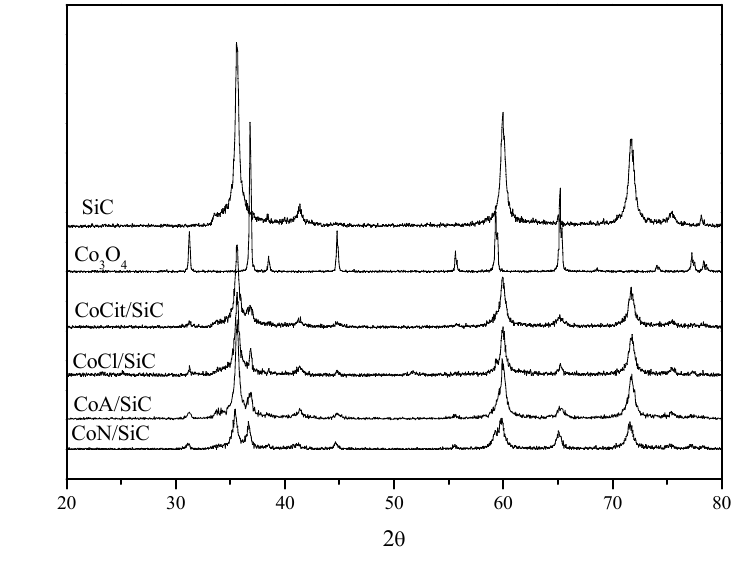
Figure 3. XRD patterns of bulk Co 3 O 4 , β‐ SiC support and catalysts Co m /SiC.